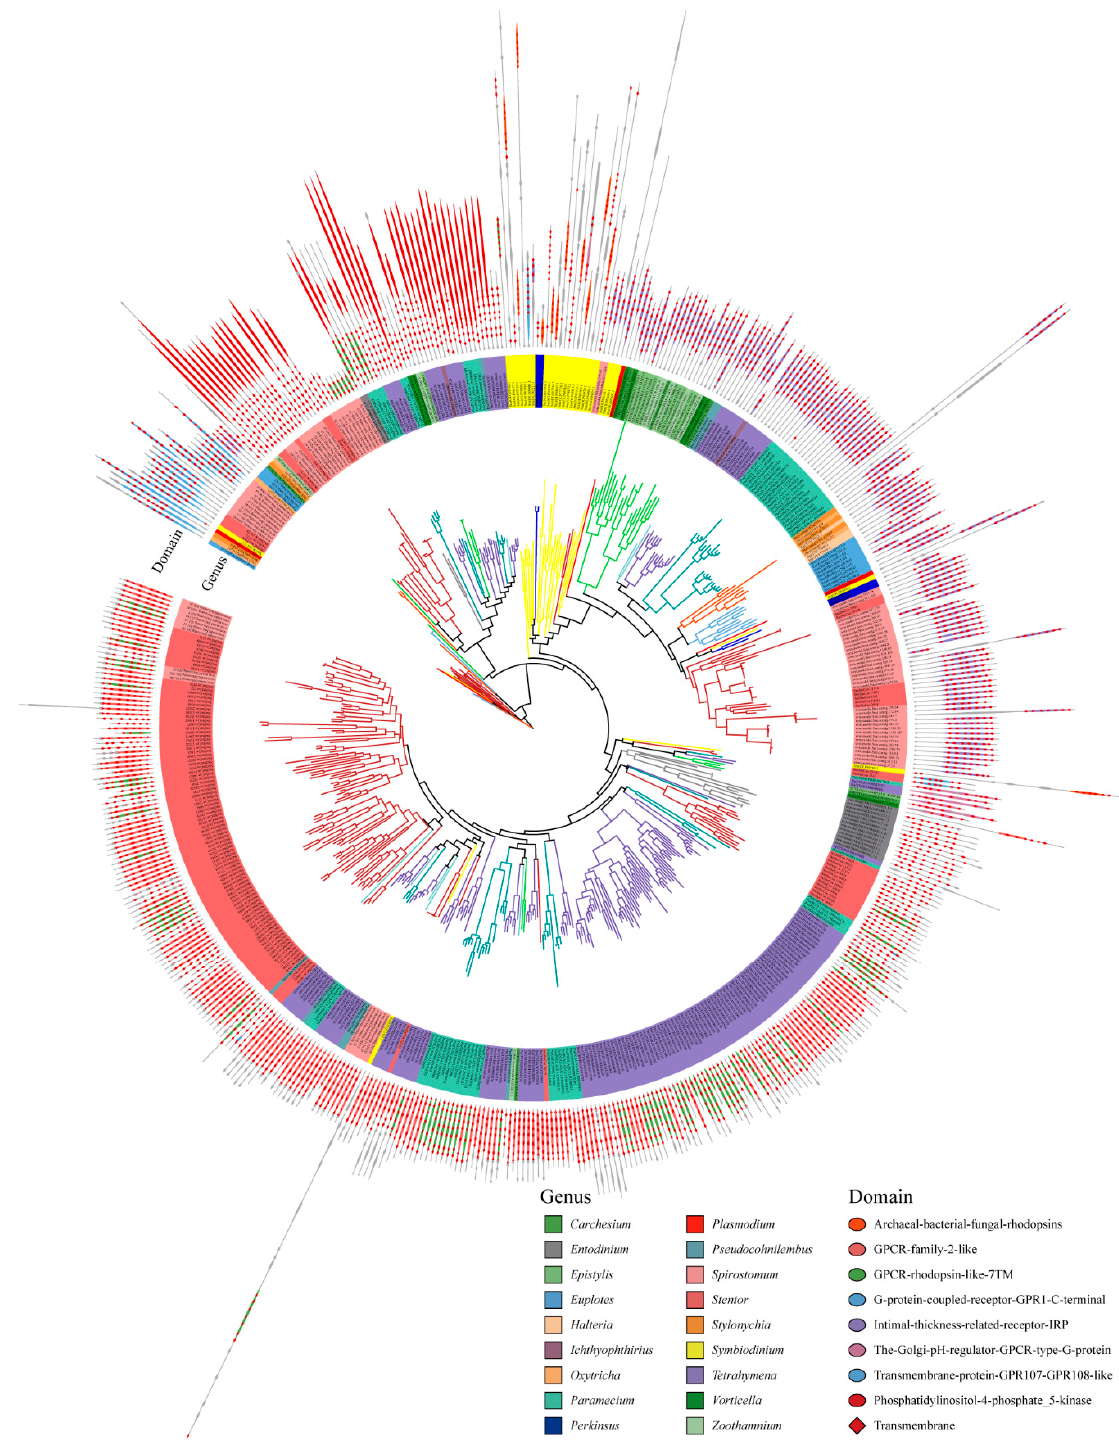
Figure 3. Phylogenetic tree and domain architectures of the GPCRs in ciliates.